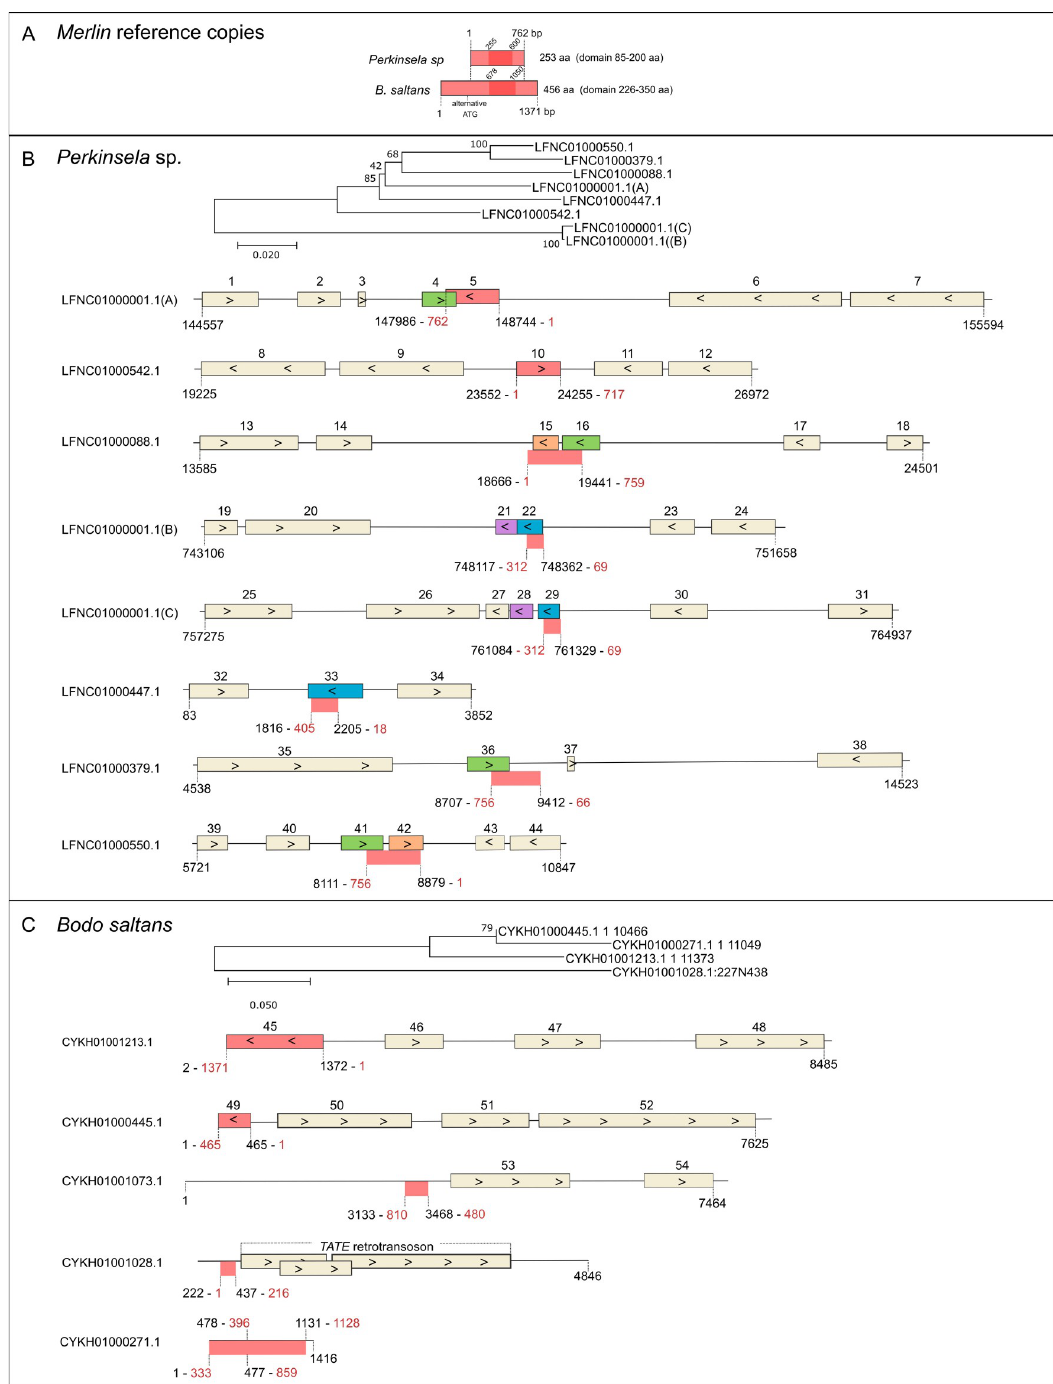
Fig 5. Merlin copies from B . saltans and Perkinsela sp. A) Representation of the most conserved Merlin copy from each species. An alternative internal ATG is shown. Both proteins possess the DDE_Tnp_IS1595 domain whose coding region is represented by dark color. B) Neighbor-joining tree of Merlin copies based on nucleotide sequences and the representation of their genomic context in the Perkinsela sp. genome. C) Neighbor-joining tree of Merlin copies based on nucleotide sequences and the representation of their genomic context in the B . saltans genome. ORFs are represented with boxes and numbers and the arrows indicate their direction. Additional information on genes is available in S6 Table. Colored boxes are related ORFs. Red boxes are Merlin copies and red boxes without an outline are the non-coding regions with similarity to Merlin protein in the tblastn. The relative position of the alignment with Merlin reference copy is written in red.